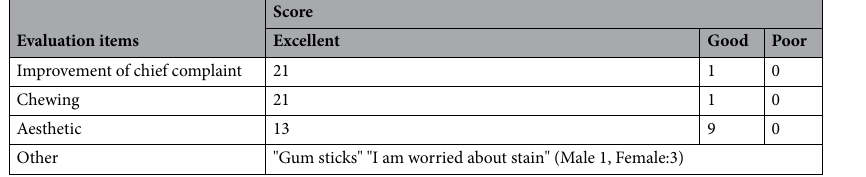
Table 6. Patient satisfaction at six months after